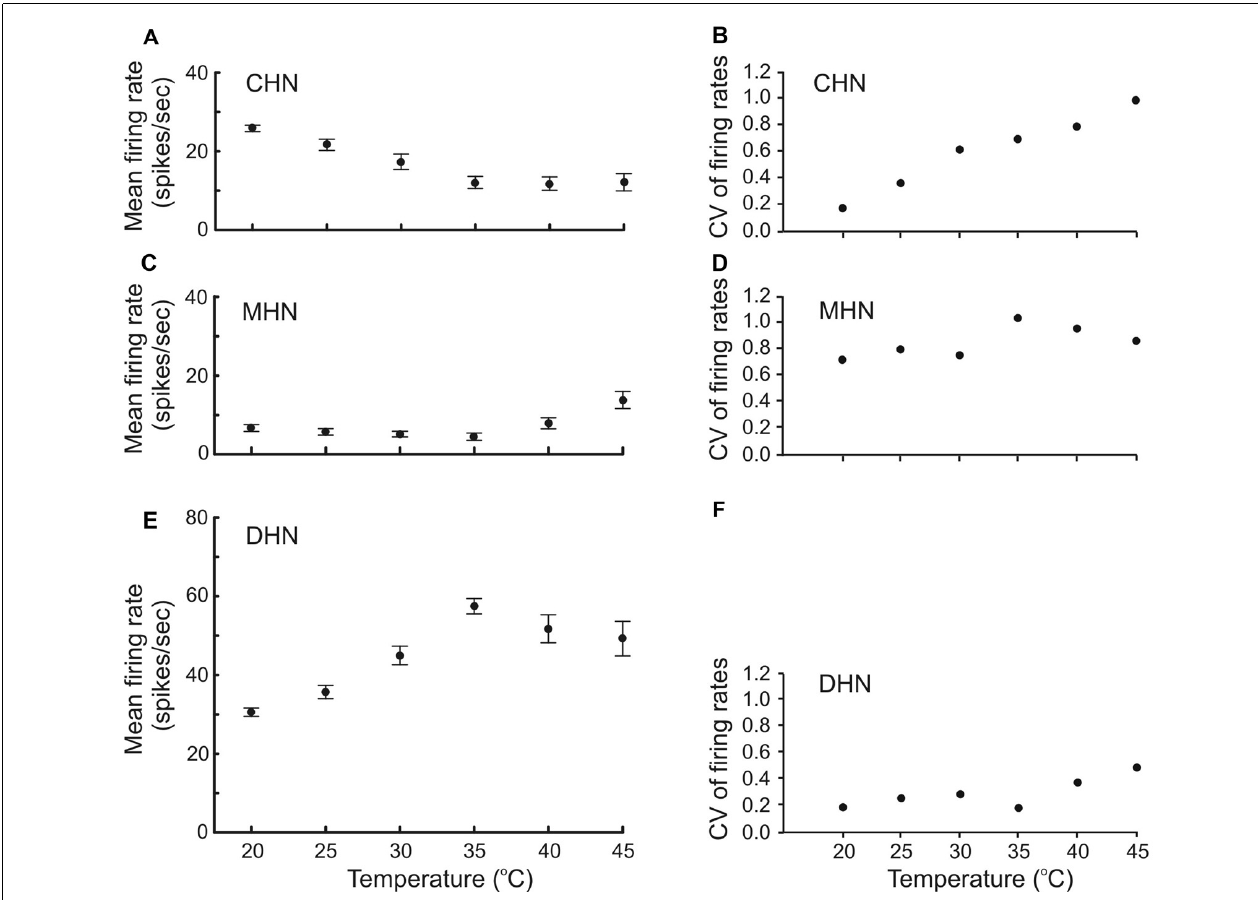
FIGURE 2 | Firing rate response of antennal DSS neurons to different levels of steady temperature (A,C,E) accompanied by their coefficent of variation (B,D,F) . Both regular spike trains and bursty spike trains of the neurons combined were subjected to the analysis. Recordings were made at constant absolute humidity 9 g m –3 condition. Note that mean firing rate of the CHN and DHN did not depend on temperature at the high end of noxious heat ranging from 35 to 45 ◦ C (A,E) . Also note that response variation of the CHN in different DSS increases with temperature increase (B) .Vertical bars show standard errors of the means. CV, coefficient of variation. The number of tested insects for each data point ( N ) =